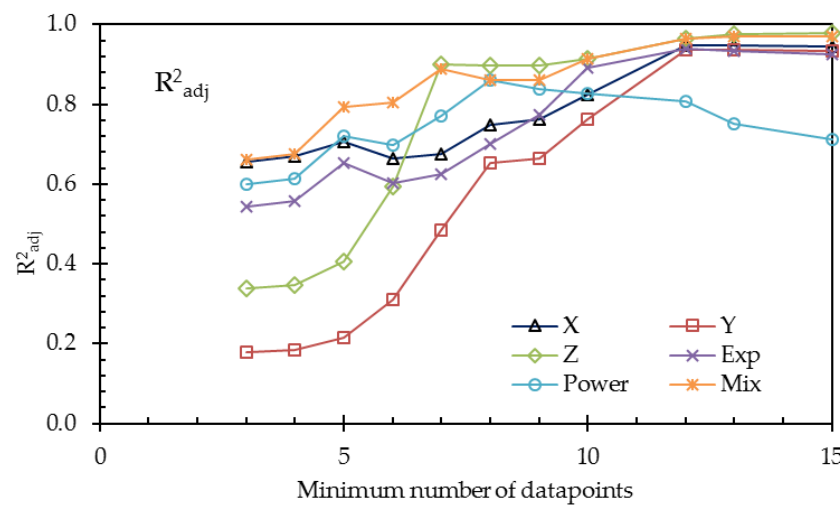
Figure 11. Mean adjusted coefficients of determination (R 2adj ) for the different models. Started with 145 datasets (some containing only 3 data points) until only 3 datasets remained (each with 15 data points).